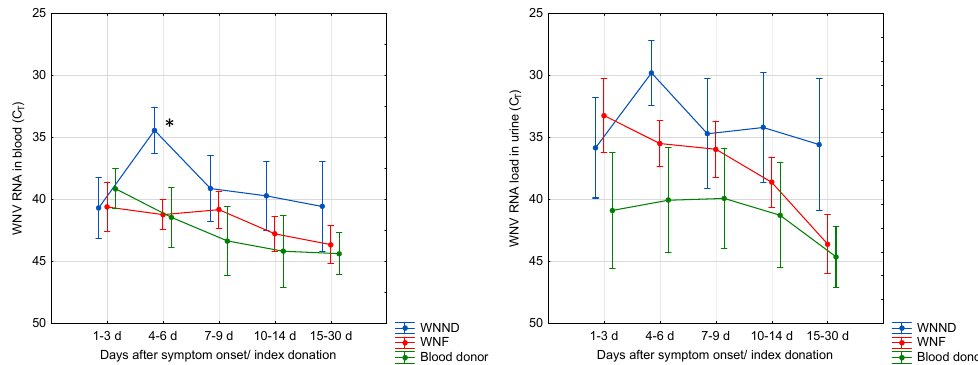
Figure 6. WNV RNA load, reported as the mean threshold cycle (C T ) values ± 95% CI, in the blood and urine of patients with West Nile neuroinvasive disease (WNND), West Nile fever (WNF), and WNV NAT-positive blood donors (blood donor). The biological samples included in the analyses are the same as those shown in Figure 4. * p < 0.05 by factorial ANOVA, WNND vs. WNF and WNND vs. WNV-positive blood donors.